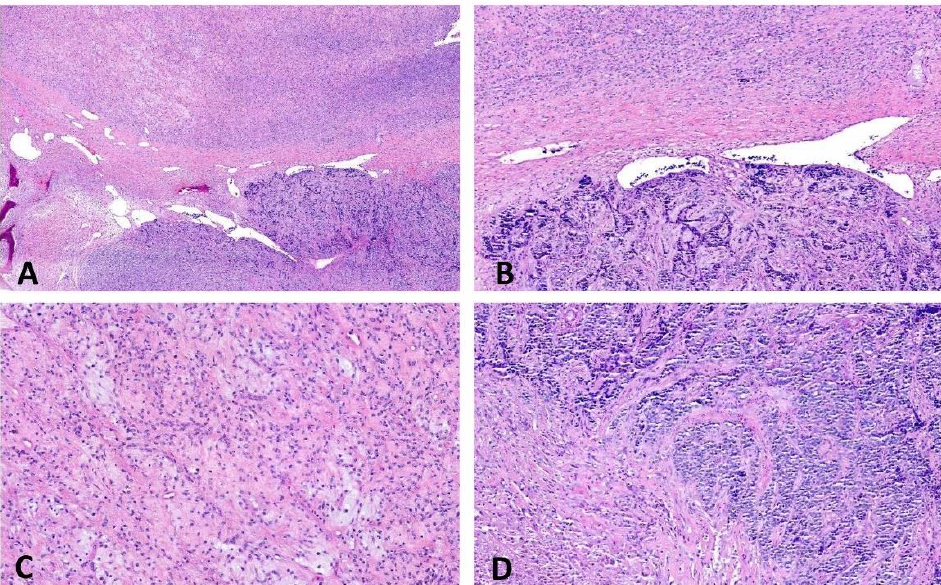
Figure 7. Histology of a high-grade bone sarcoma with EWSR1::NFATC2 fusion (case #5). ( A , B ) Tumor is composed of low- (upper part) and high-grade (lower part) areas. ( C ) Low-grade component consists of cords of monomorphic round to epithelioid cells embedded in a myxohyaline stroma. ( D ) High-grade component is hypercellular and composed of anastomosing cords and trabeculae of highly atypical round cells embedded in a collagenous matrix with area of necrosis.